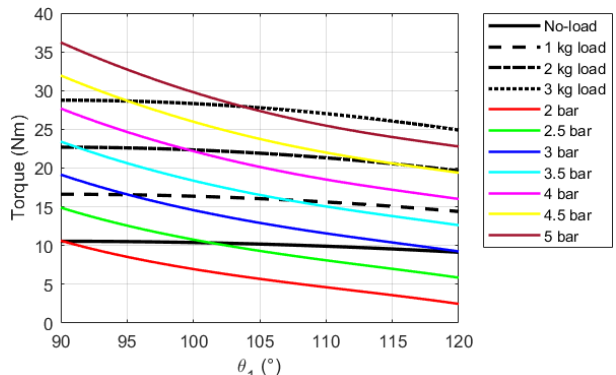
Figure 8. Gravitational torque in no-load (black line) and 1kg (dashed black line), 2kg (dot-dashed black line), and 3kg (dotted black line) loaded conditions as well as torque exerted by the ex- oskeleton at different supply pressures by employing the DMSP- 20-200N muscle and the cam profile with r i =